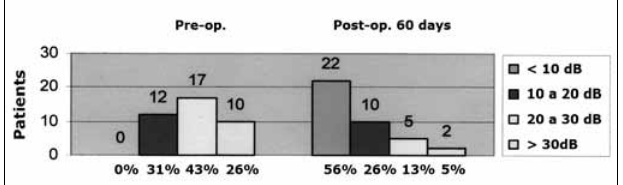
Chart 3. Audiometry of the air-bone gap before and after surgery (60th postoperative